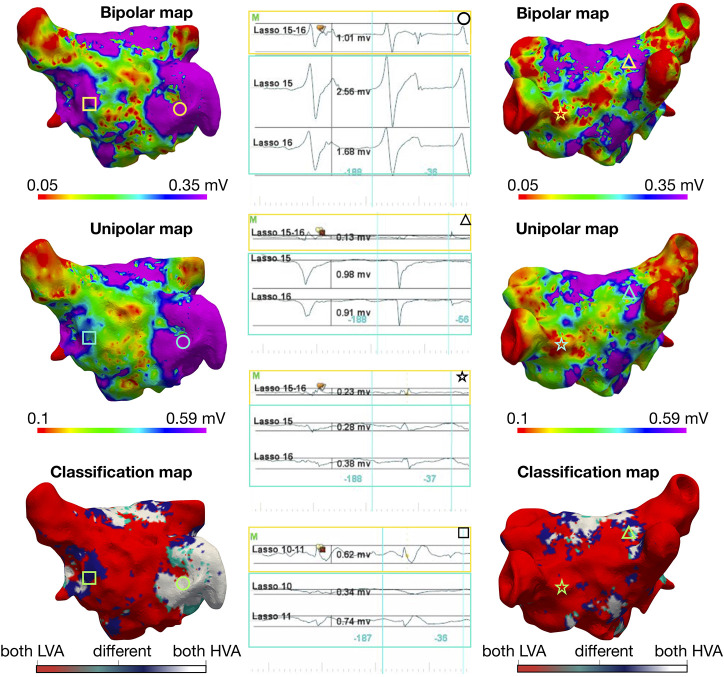
Voltage mapping in atrial fibrillation: Three-dimensional distribution of bipolar and unipolar LVA in the same patient as Figure 1 during AF with a bipolar threshold <0.35 mV. The top row indicates the bipolar map, the middle row shows the unipolar map, and the bottom row is a map of the point by point comparison between the two maps: if both points are below their indicated voltage thresholds (LVA), the point is colored red, if both are above [high voltage areas (HVA)] in white and with different classification (bipolar low voltage, unipolar high voltage) in dark-blue and (bipolar high voltage, unipolar low voltage) in turquoise. In the left column, the anterior view is shown and on the right the posterior view. Each geometric shape represents a point on the map where the corresponding signal is shown in the middle column. The electrogram marked with a triangle is an example of “voltage cancelation” in the bipolar recording (0.13 mV), while the voltages on both unipolar recordings are high (0.98 and 0.91 mV); this occurs because the unipolar electrograms have the same shape and same timing and their subtraction results in a near-zero bipolar voltage value.The upper unipolar threshold values was obtained by determining which threshold provided the best match of points between unipolar and bipolar. The lower value was selected manually to obtain the best visual match.